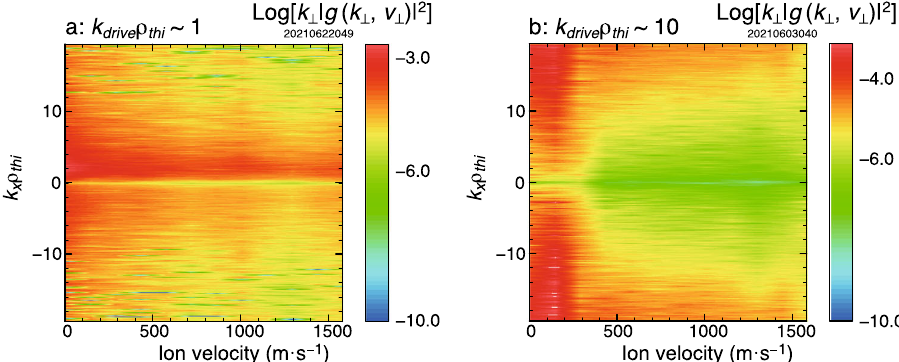
Fig. 1 Spectra of free energy in the wavenumber – velocity space. Time-averaged power spectra k ⊥ | g ( k ⊥ , v ⊥ )| 2 measured by RIDFPs as functions of the wavenumber k x normalized by the ion Larmor radius ρ thi at the thermal velocity v thi and the perpendicular ion velocity v ⊥ up to ~2 v thi for a driving perpendicular wavenumbers k drive ρ thi ~ 1 and b k drive ρ thi ~ 10,